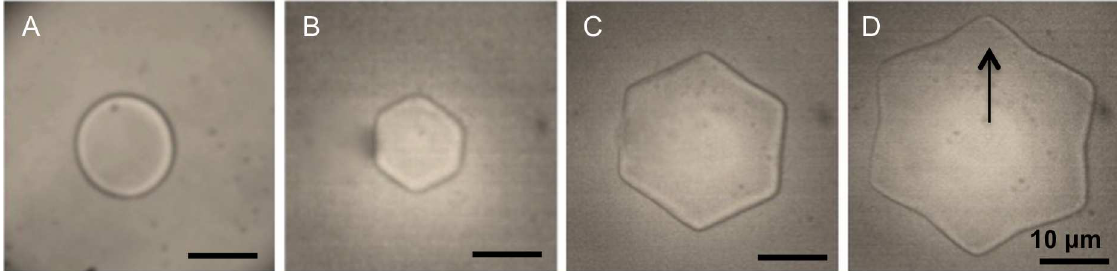
Fig 6. Ice crystalshaping of wild-type B . distachyon lysates. The morphologyof ice crystals formed in the presenceof lysates of non-acclimated B . distachyon (A) was comparedto those producedby cold-acclimated (CA) B . distachyon lysates (B). The ice crystal “burst” observedin the presenceof CA lysates is shown in panels (C) and (D). The arrow indicatesthe directionof the a- axis in one of the images. Assays were conductedusing 0.5 mg/mL of total protein, in